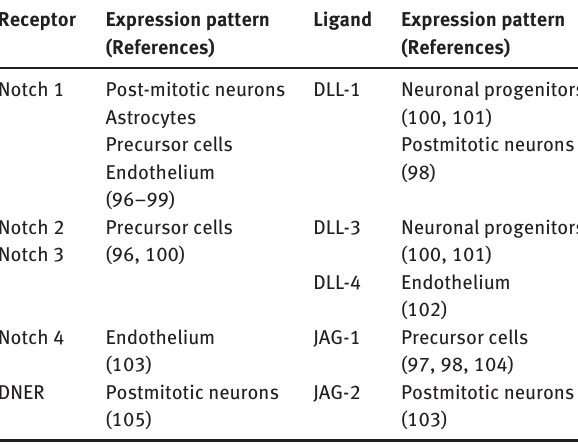
Table 1 Notch signaling in the adult brain: ligands, receptors, and expression